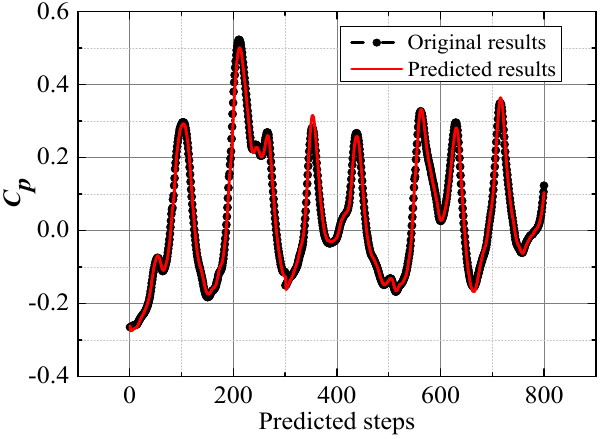
Figure 7. Predicting results of KKF-VSM with one-order.